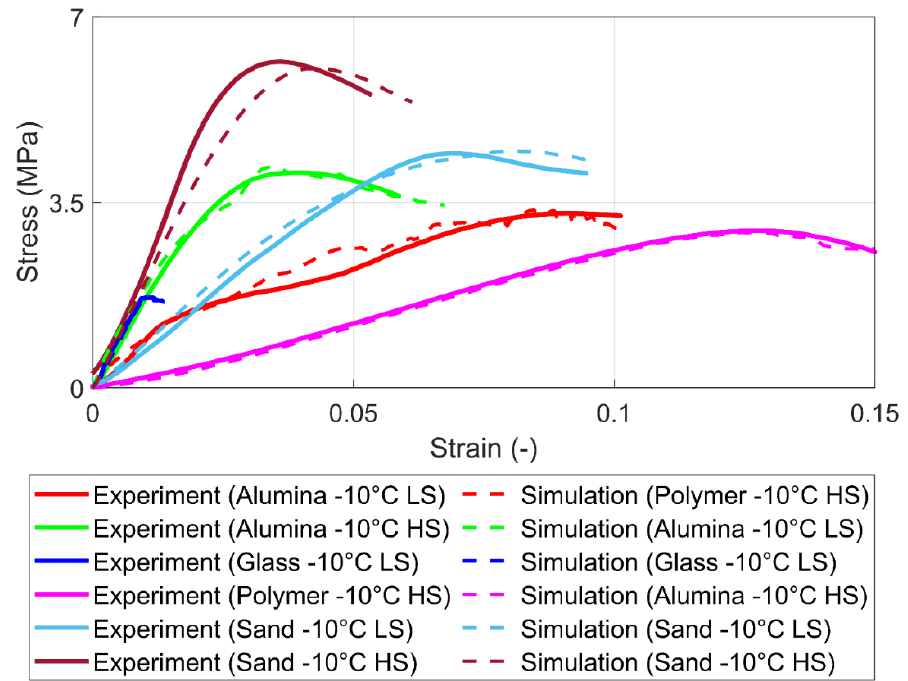
Figure 10. Experimental and simulation results for 100% saturation level for high strain (HS) rates (10 − 2 s −1 ) and low strain (LS) rates (10 −3 s −1 ).